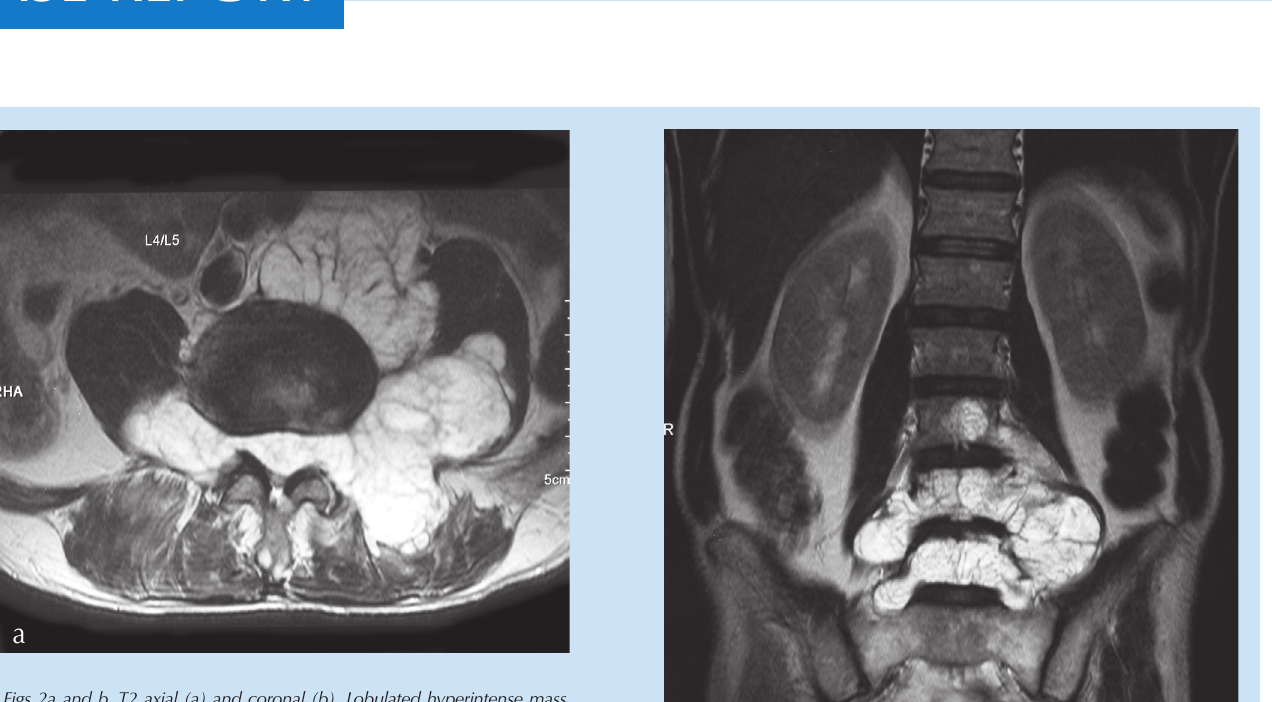
Figs 2a and b. T2 axial (a) and coronal (b). Lobulated hyperintense mass infiltrating spinal canal as well as paravertebral muscles.